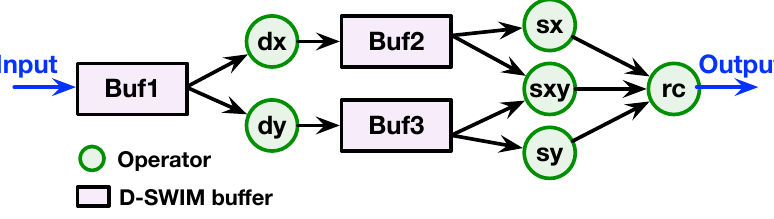
Figure 14. D-SWIM-based architecture for HC detector (3 × 3